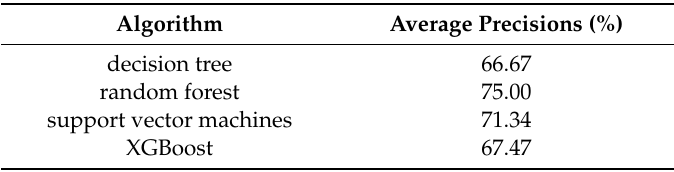
Table 1. Validation of the calibrated